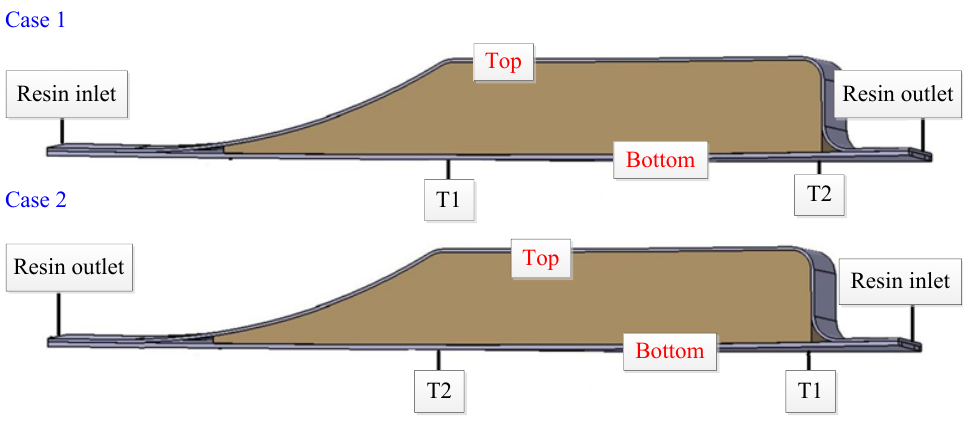
Figure 6. Resin flow front position under different injection cases. Table 1. Comparison of flow front times at different positions of spoilers.